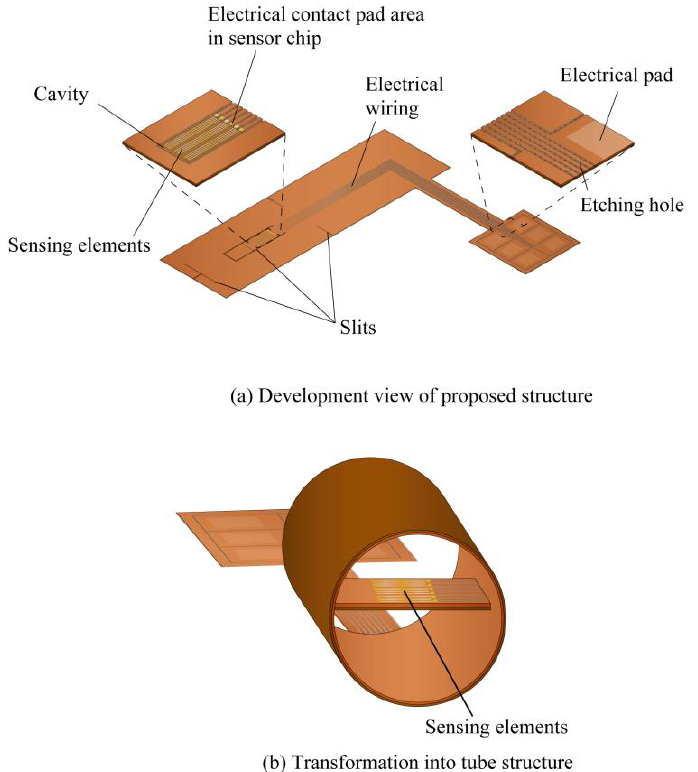
Figure 5. Schematic of the proposed flow sensor. Development of the sensing element fabricated on a COP substrate ( a ). The substrate deformed into a tube structure ( b ).